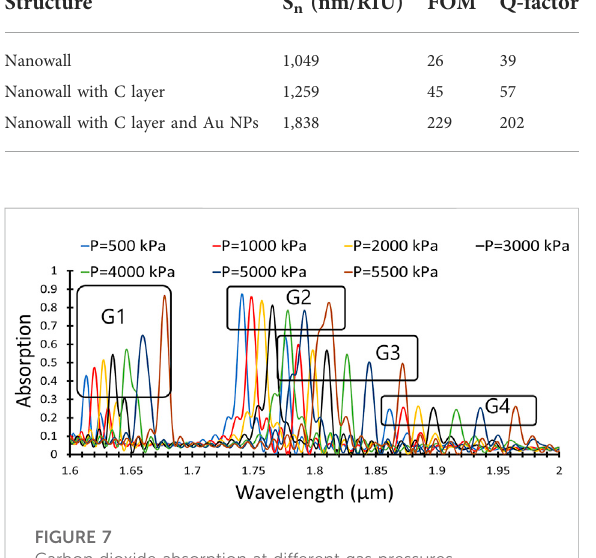
FIGURE 7 Carbon dioxide absorption at different gas pressures.